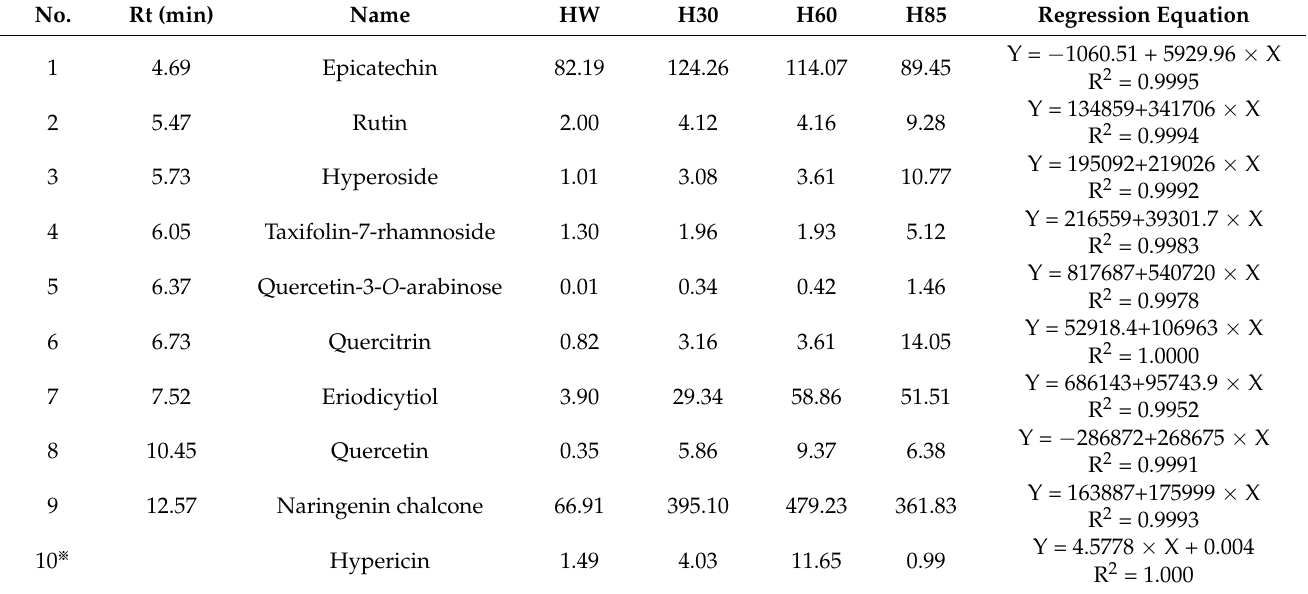
Table 3. Content of the 10 active compounds in the extracts of H. kouytchense insect galls ( µ